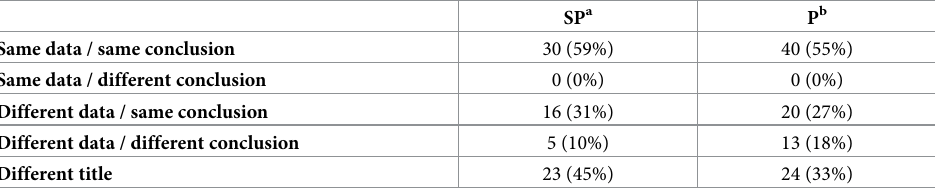
Table 2. Differences between the preprint and its published